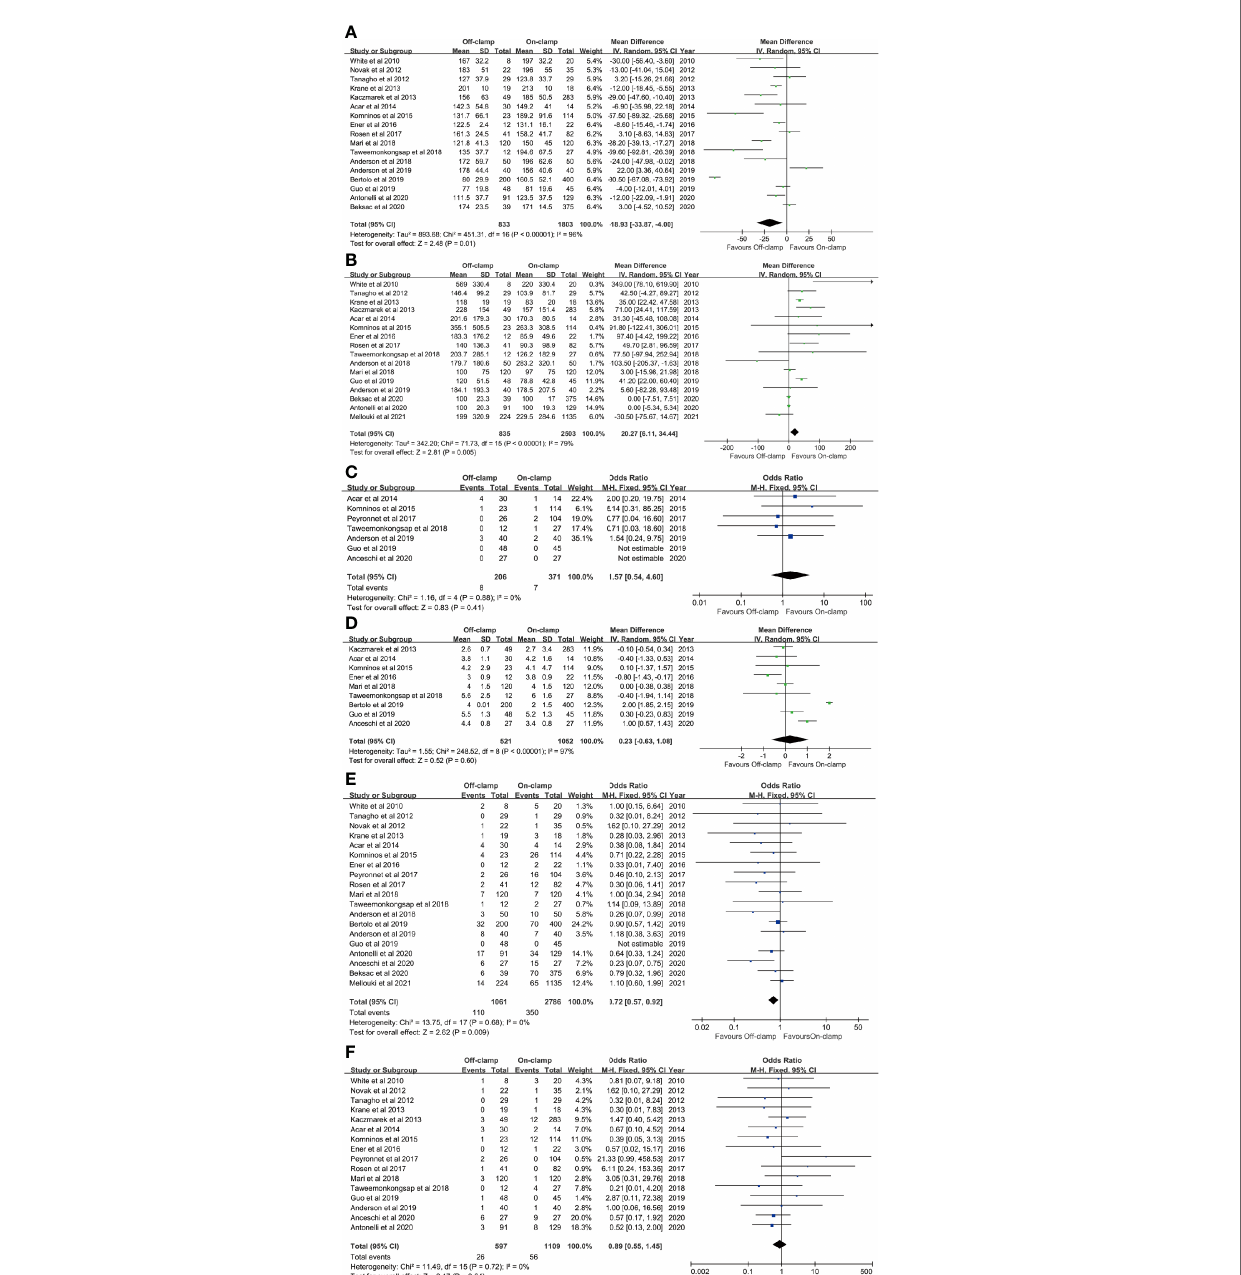
FIGURE 2 | Forest plots of perioperative outcomes: (A) operating time, (B) estimated blood loss, (C) conversion rate, (D) length of stay, (E) complication rate, and (F) transfusion